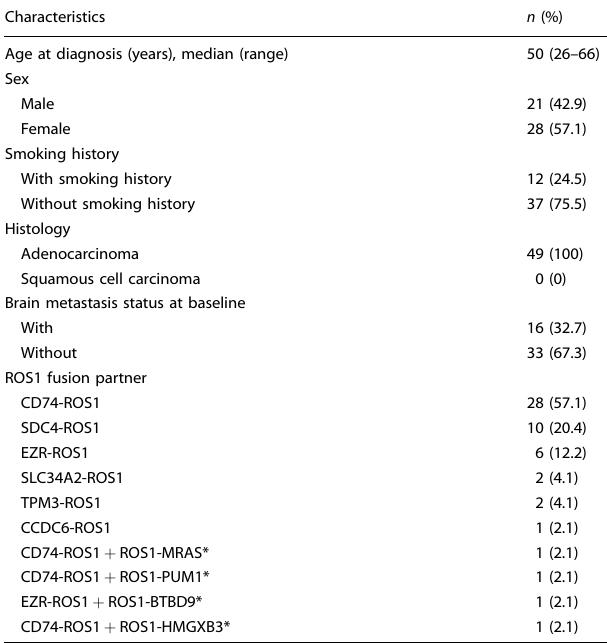
Table 1. Baseline characteristics of 49 Crizotinib-treated patients with advanced NSCLC who provided rebiopsy samples for NGS detection at crizotinib progression.